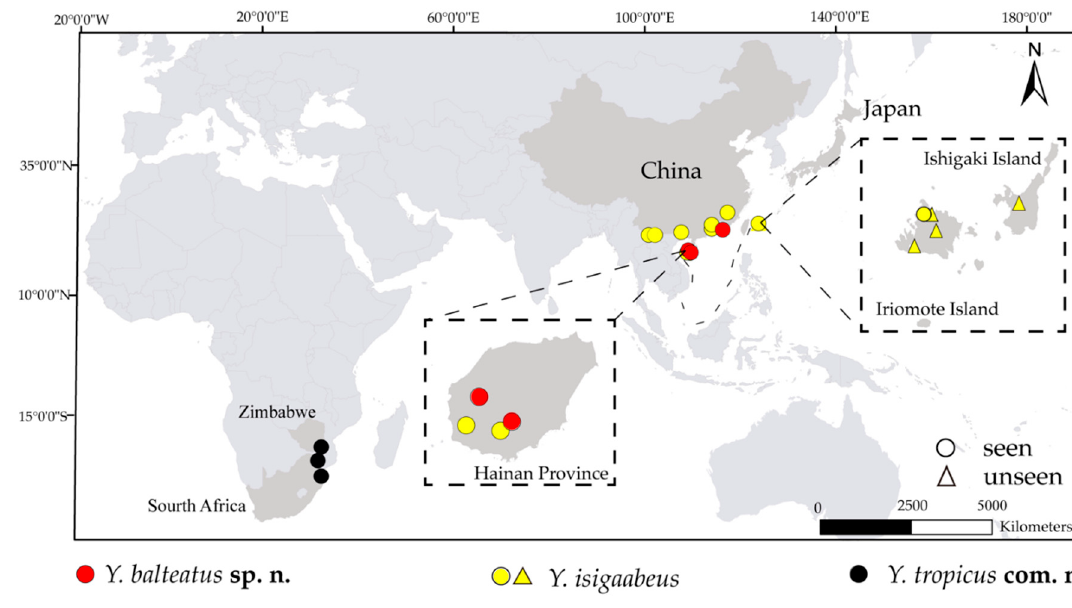
Figure 1. Distribution map of Yaeprimus .